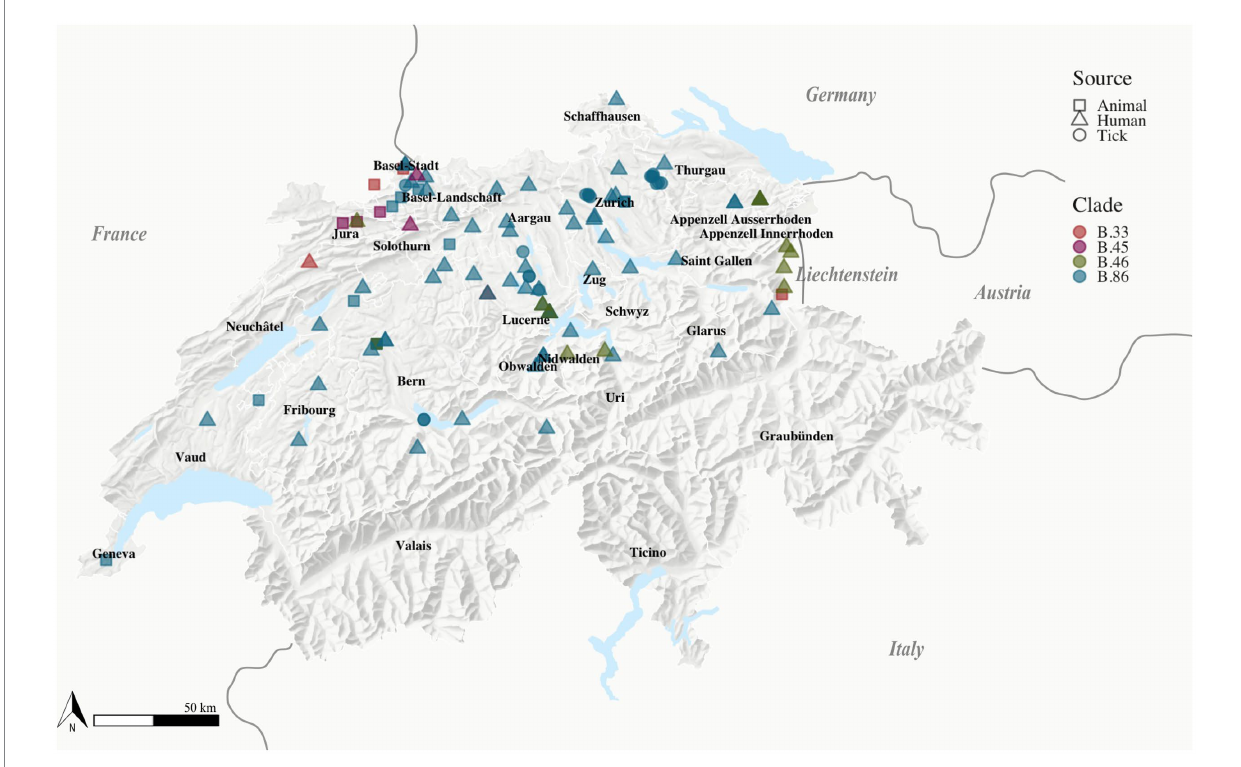
FIGURE 2 Location of Fth isolates. Fth isolates ( n = 111) with known geographic locations obtained from tick ( n = 18), animal ( n = 20), and human ( n = 73) sources labeled according to their clade [B.33 ( n = 5), B.86 ( n = 5), B46 ( n = 12), B45 ( n = 89)], Switzerland, 2007–2022. The geographical location of the isolates obtained from human sources was represented by the patients’